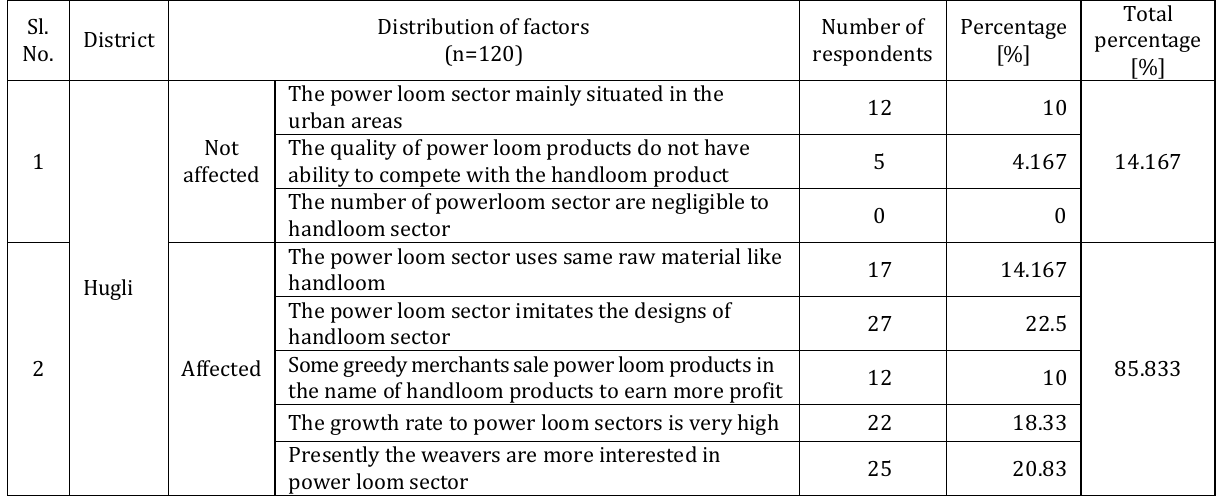
Table 3. Table showing effect of power loom sector on handloom weaving (Source: Primary survey 2017–2018)